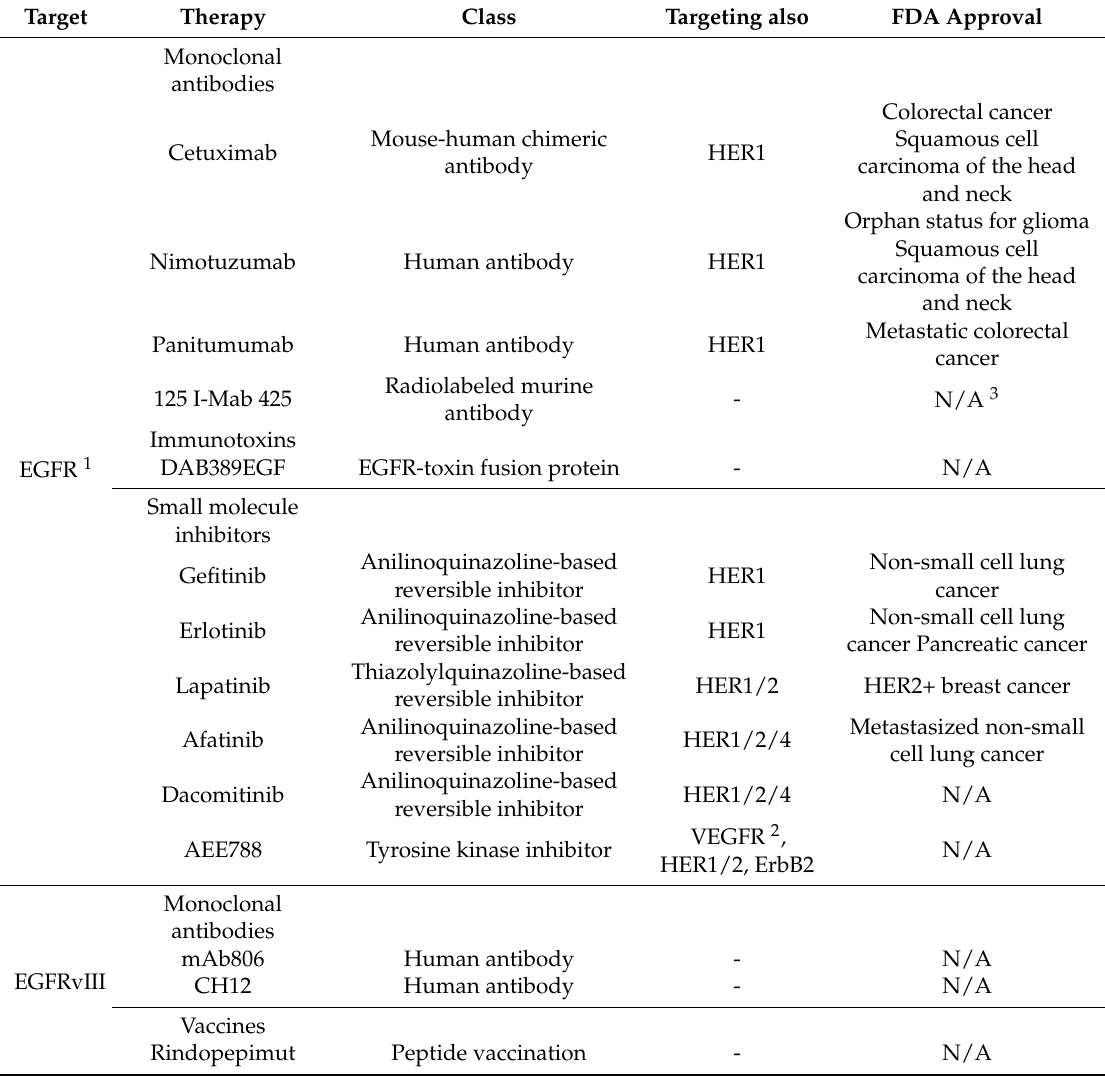
Table 1. Selection of EGFR and EGFRvIII